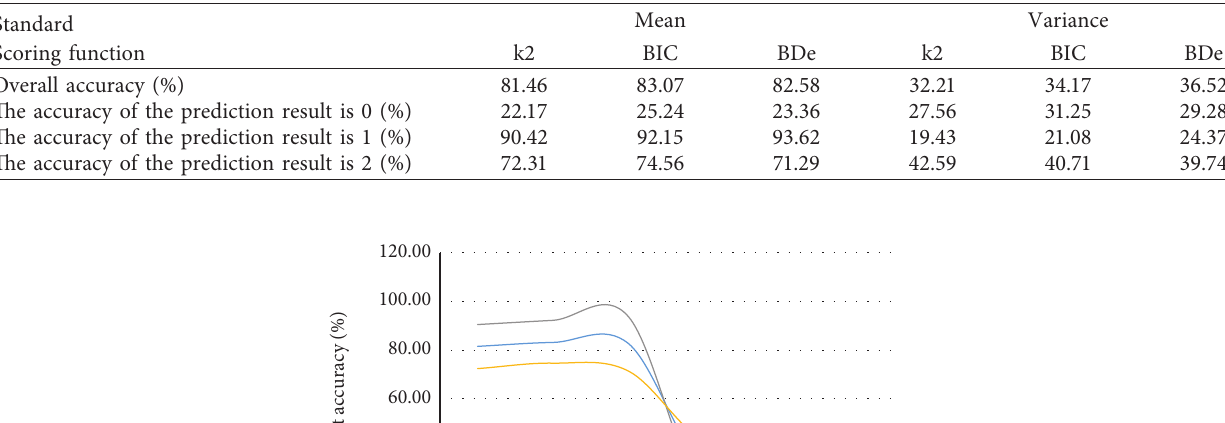
Table 3: Comparison results of the three scoring functions.